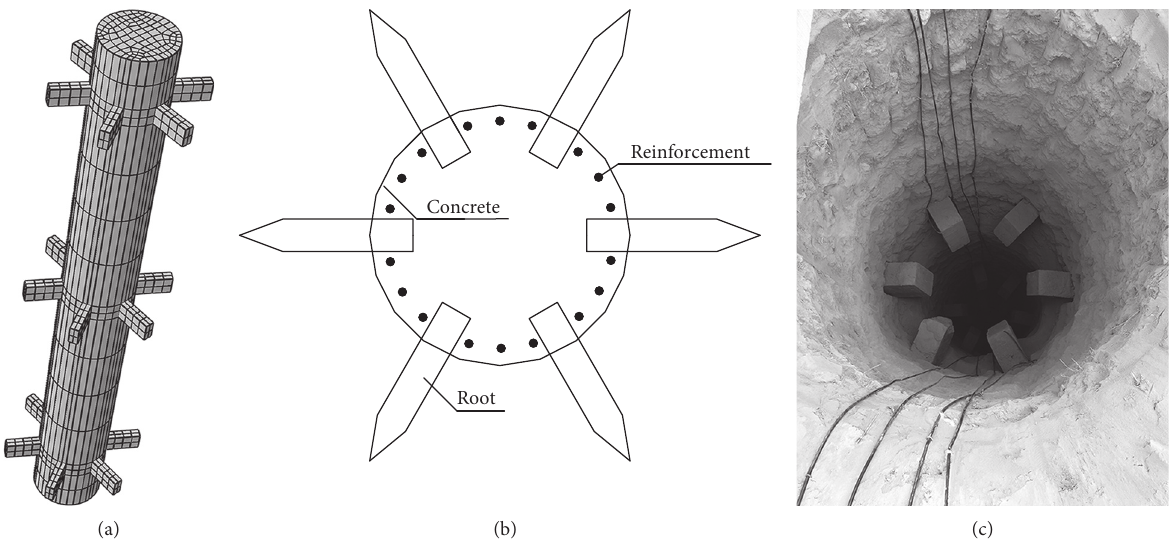
Figure 1: Diagram of RP. (a) Elevation of RP. (b) Layout of roots. (c) Site picture of roots after pushing.